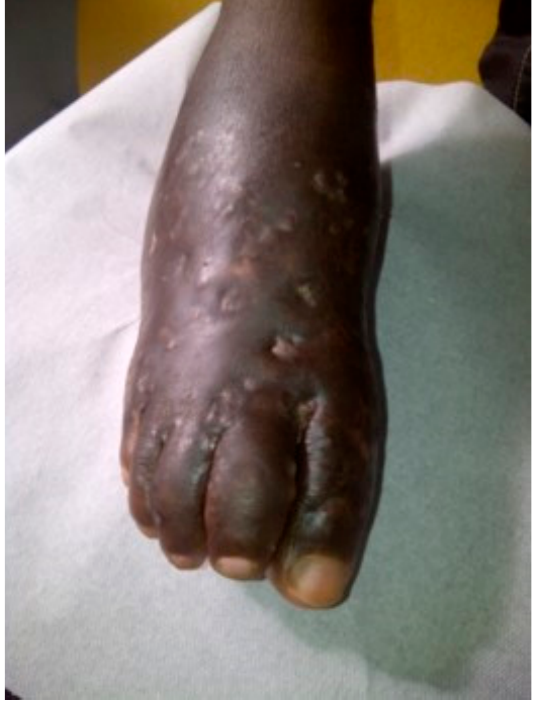
Figure 1. Black-grain eumycetoma in a Senegalese patient.